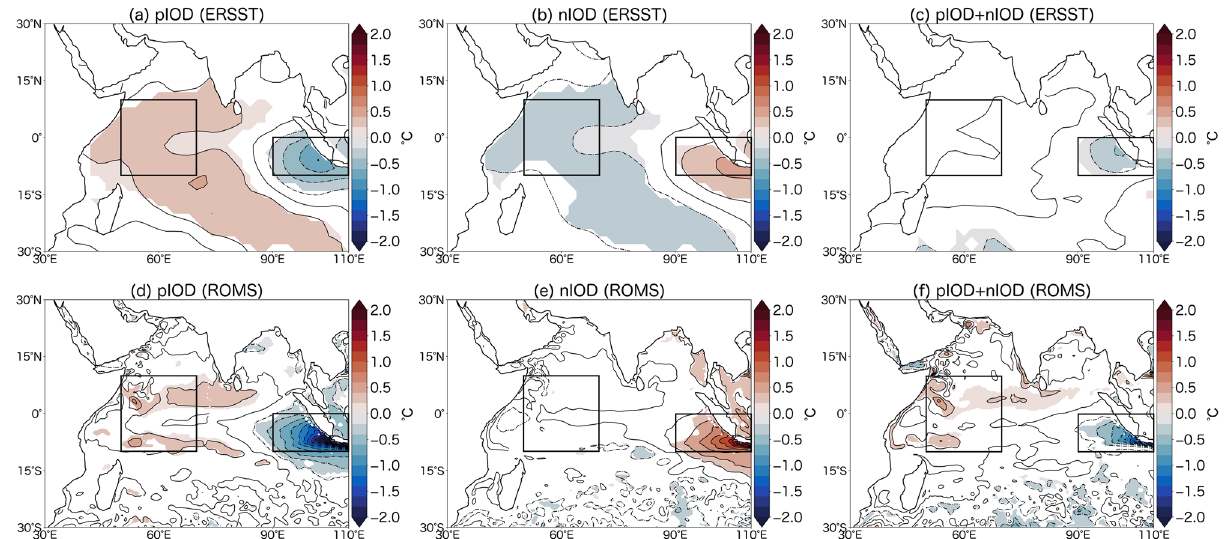
Figure 1. Sea surface temperature (SST) anomalies associated with the positive Indian Ocean Dipole (pIOD) and negative Indian Ocean Dipole (nIOD). Composites of SST anomalies (in °C) during September (0) to November (0) of pIOD years (left) and nIOD years (middle) from the ERSST ( a – c ) and the ROMS ( d – f ). Their sums (i.e., pIOD plus nIOD) are also presented (right). The contour intervals are 0.2 °C. Anomalies significant at the 95% confidence level by a two-tailed t test are shaded. The boxes represent the western and eastern poles of the Indian Ocean Dipole (IOD). Although an asymmetric component is often expressed in terms of (pIOD + nIOD)/2, figures in this paper use pIOD + nIOD to ease comparison with past studies on the SST asymmetry of the